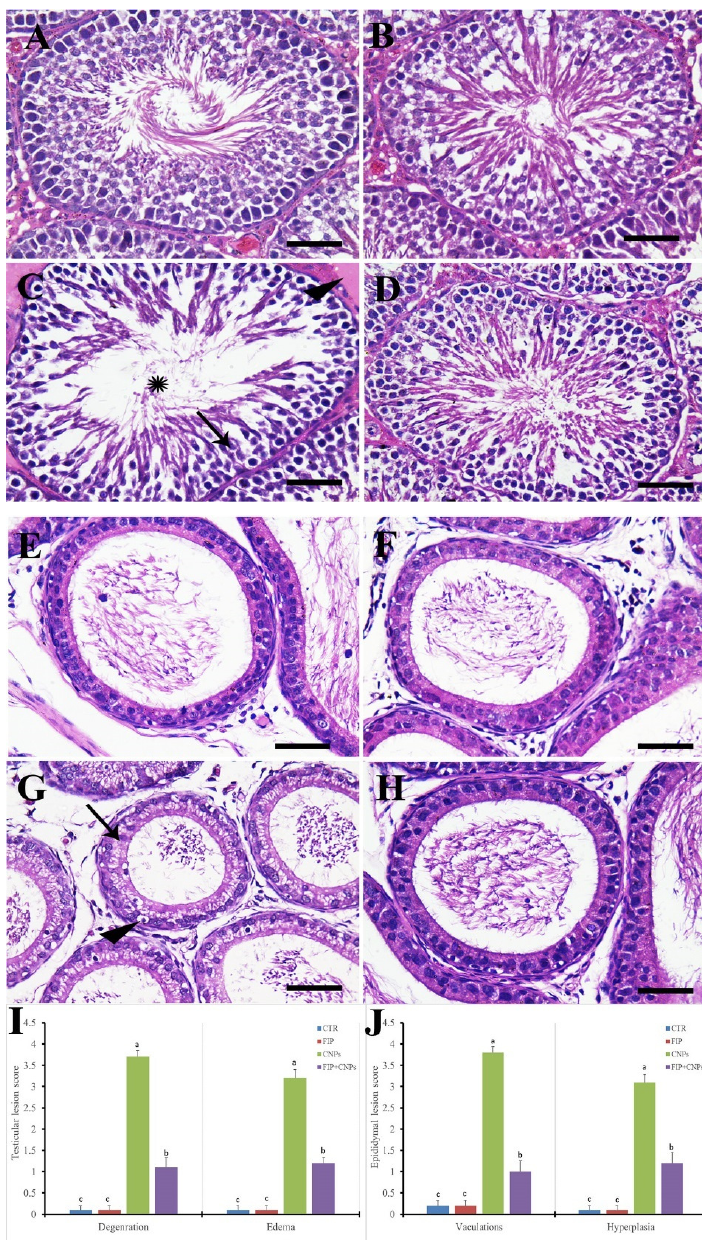
Figure 1. Histopathological examination of rat testis. ( A ) Testicular control, and ( B ) CeNPs groups. ( C ) FIP group revealed edema (arrowhead), degeneration in the different stages of the seminiferous tubules (thin arrow), and fewer spermatozoa in the lumen (asterisk). ( D ) FIP treated with CeNPs. ( E ) Negative epididymal control group. ( F ) CNPs group. ( G ) FIP group showed the phospholipidosis-mediated vacuolations (arrow), hyperplasia and apoptosis of halo cells in the epididymis (arrowhead). ( H ) FIP treated with CeNPs. Scale bar = 50 µm. ( I ) H&E semi-quantitative scores of testicular degeneration and edema. ( J ) H&E semi-quantitative scores of epididymal hyperplasia and vacuolations. Data expressed as mean ± SE, analyzed using one-way ANOVA at p ≤ 0.05. The PAS-stained epididymis in both control and CeNPs groups showed a normal